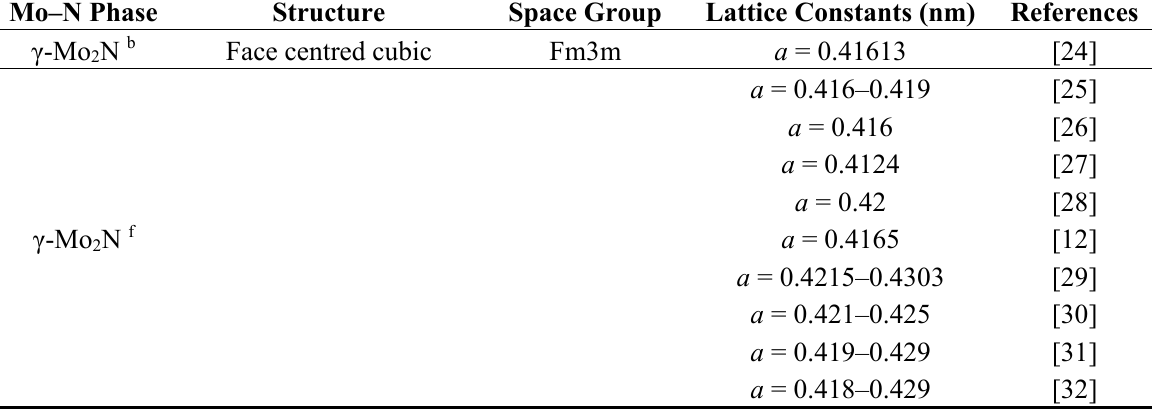
Table 1. Lattice parameters of Mo 2 N films ( f ) compared with bulk ( b ), and theoretical values ( th ). Mo–N